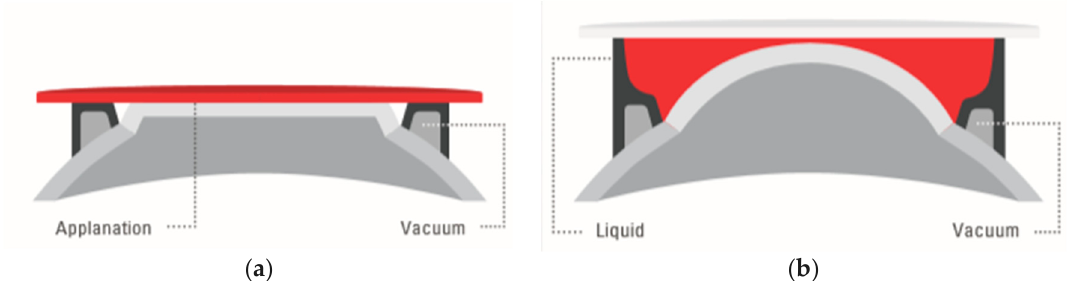
Figure 8. Typical patient interface designs: ( a ) contact interface in direct touch with the cornea (flat or curved), and ( b ) liquid optics interface, no direct touch on the cornea, no deformation.